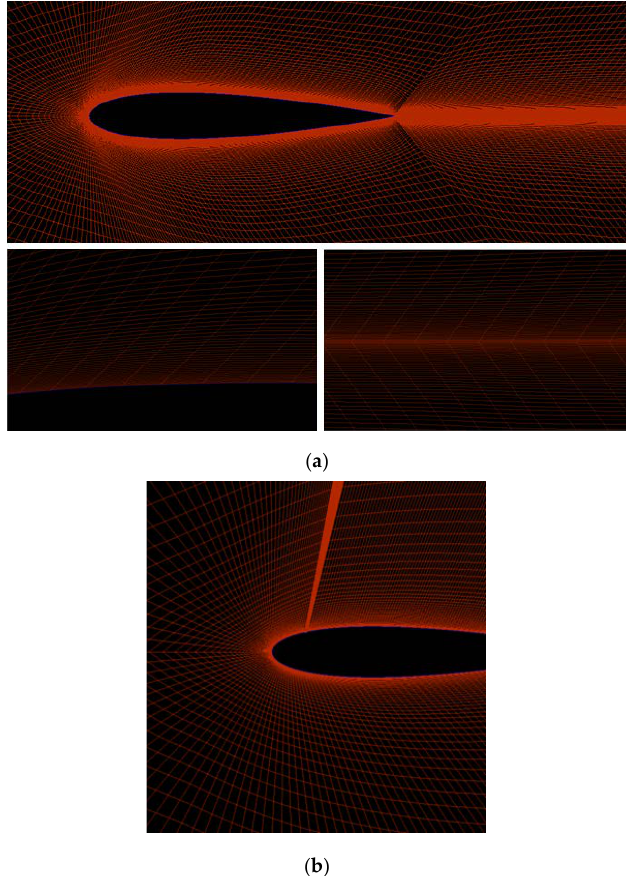
Figure 3. Mesh structure for cases without SJA and with SJA , ( a ) Mesh clustering around airfoil surfaces, and ( b ) dense in the vicinity of the synthetic jet actuator.